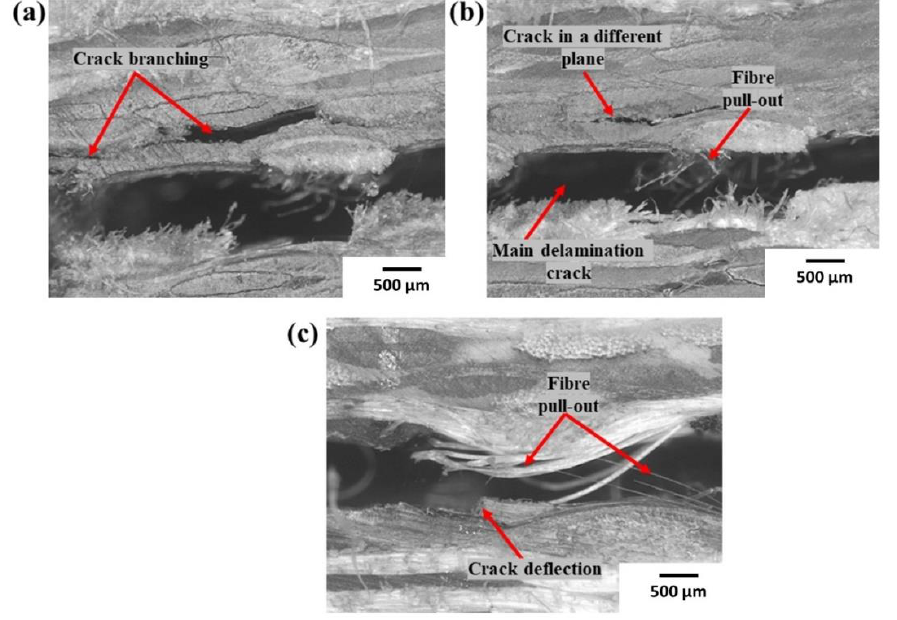
Figure 12. Micro-photographs of side surfaces of ( a , b ) Carbon_UHMWPP and ( c ) Carbon_UHMWPE Figure 12 . Micro-photographs of side surfaces of ( a , b ) Carbon_UHMWPP and ( c ) Car- bon_UHMWPE reinforced thermoplastic composites . reinforced thermoplastic